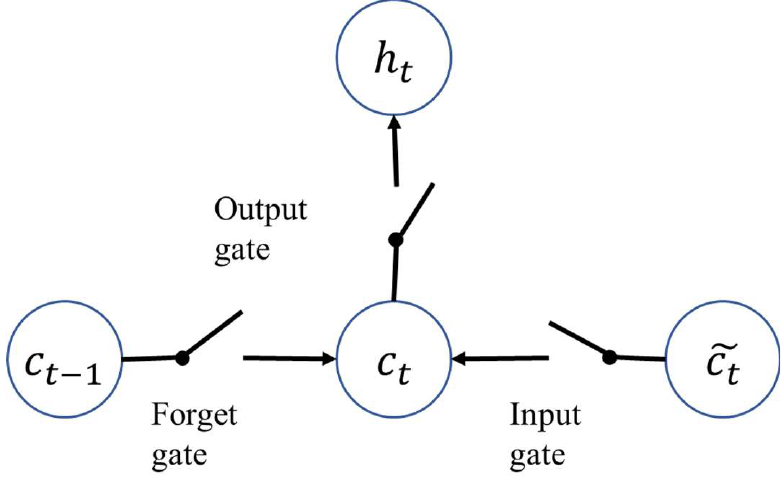
Figure 6. Schematic of LSTM cell.